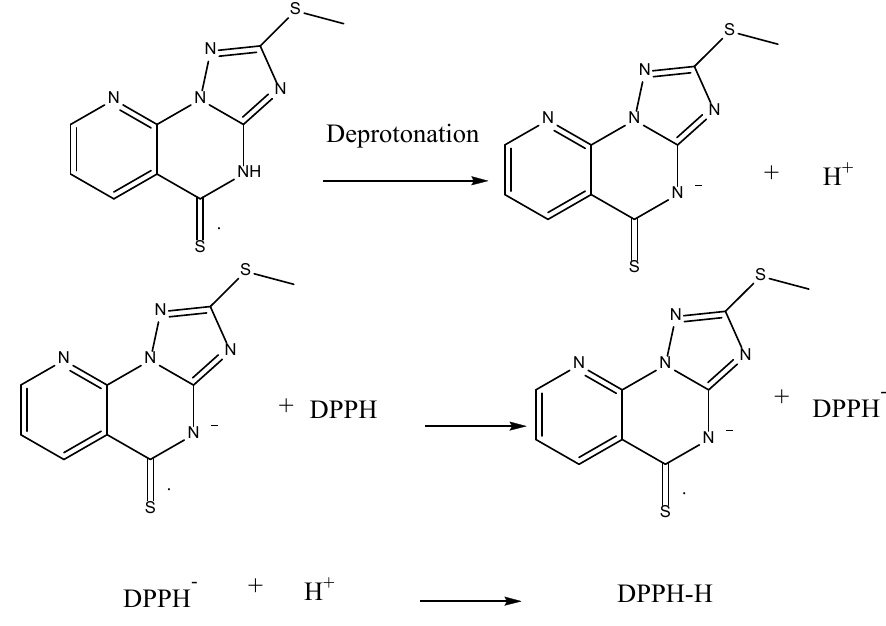
Scheme 2: Reasonable mechanism of the redox reaction or antioxidant activity of product